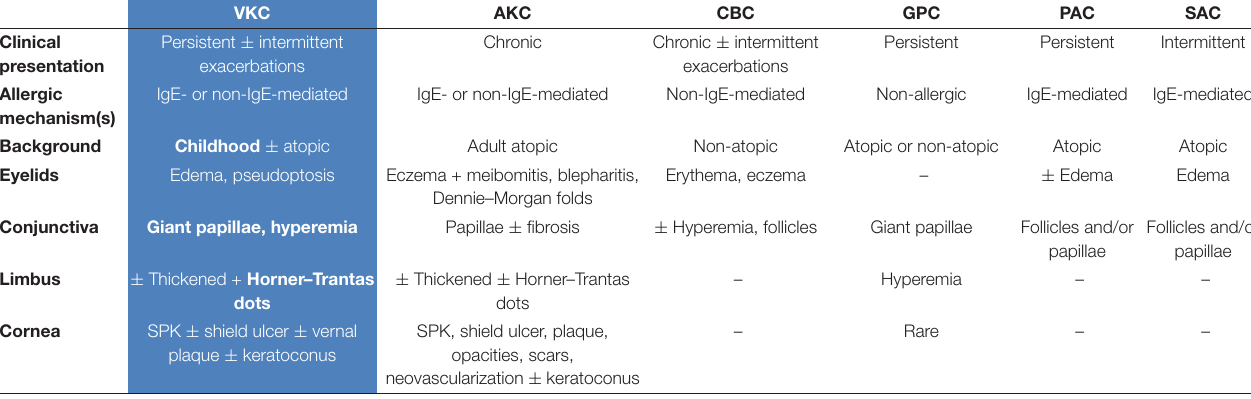
TABLE 2 | Clinical features of major ocular allergy syndromes, including the underlying hypersensitivity mechanism and ophthalmological presentation